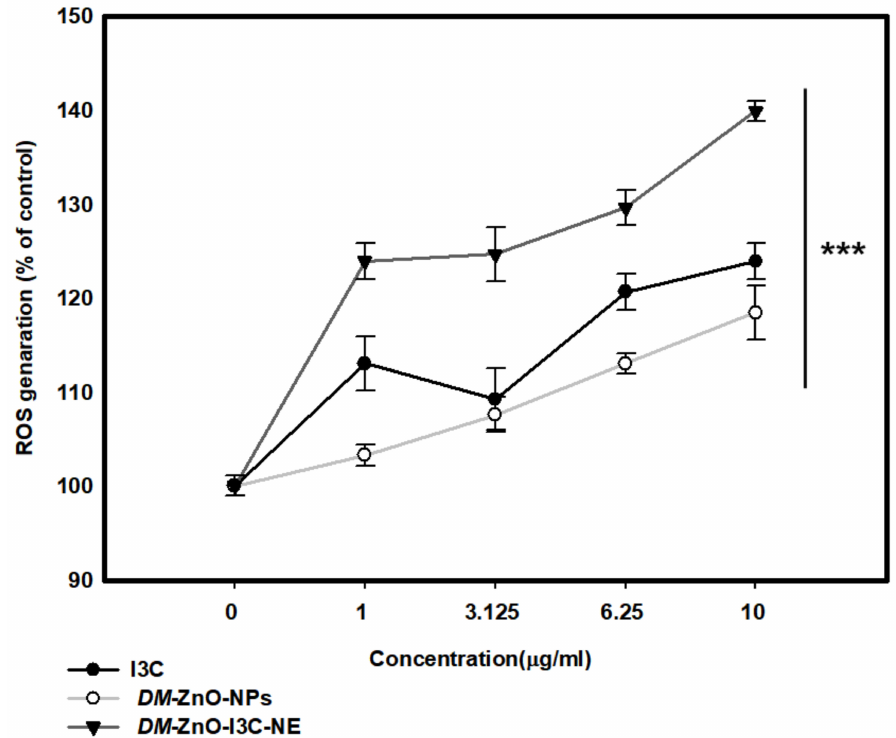
Figure 9. Reactive oxygen species (ROS) generation ability of DM -ZnO-NE with compared free drug in A549. Each value is expressed as the mean ± standard error of three independent experiments. *** p < 0.001 compared with